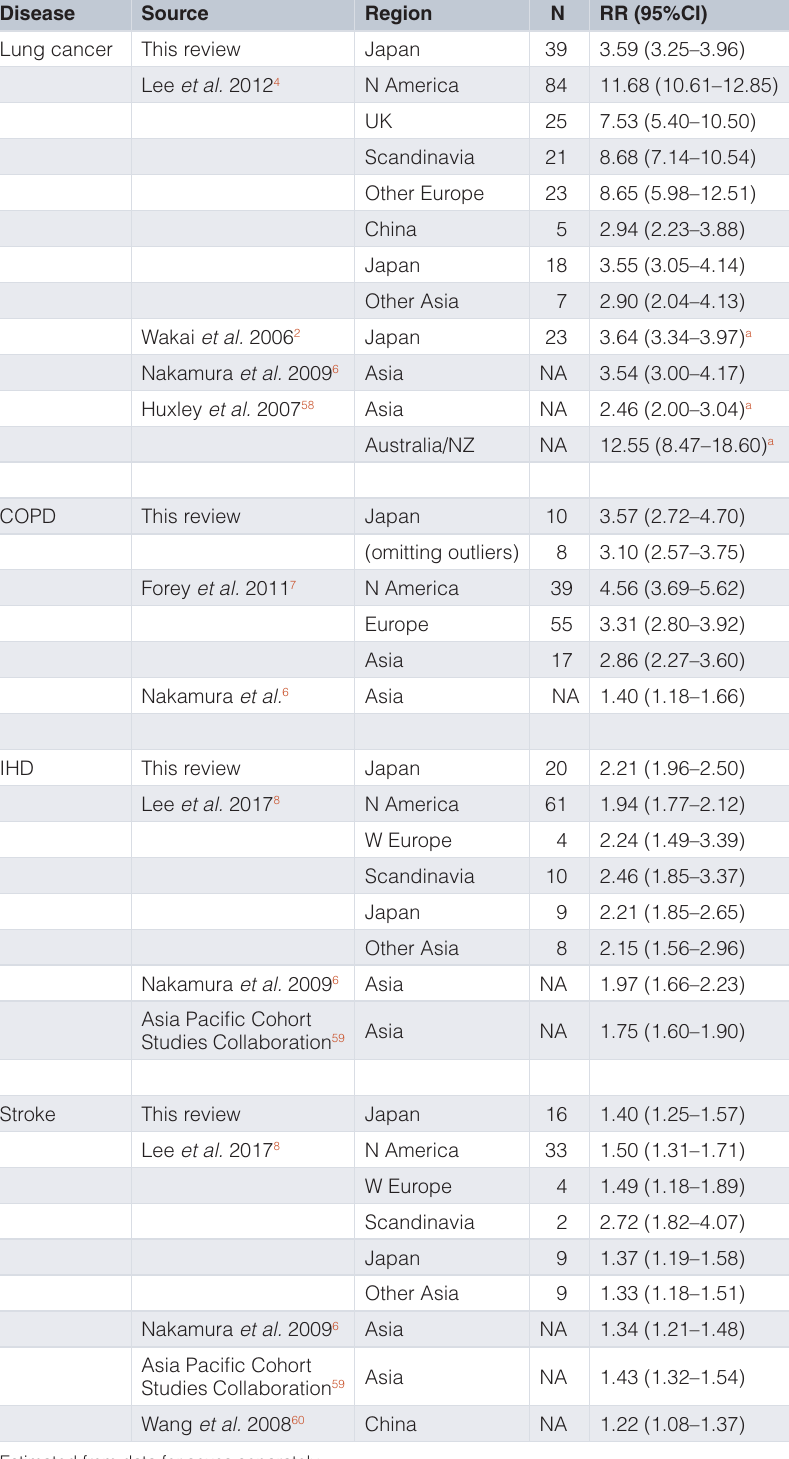
Table 7. Current smoking relative risks in the present study compared with those reported in other studies in Japan and elsewhere.